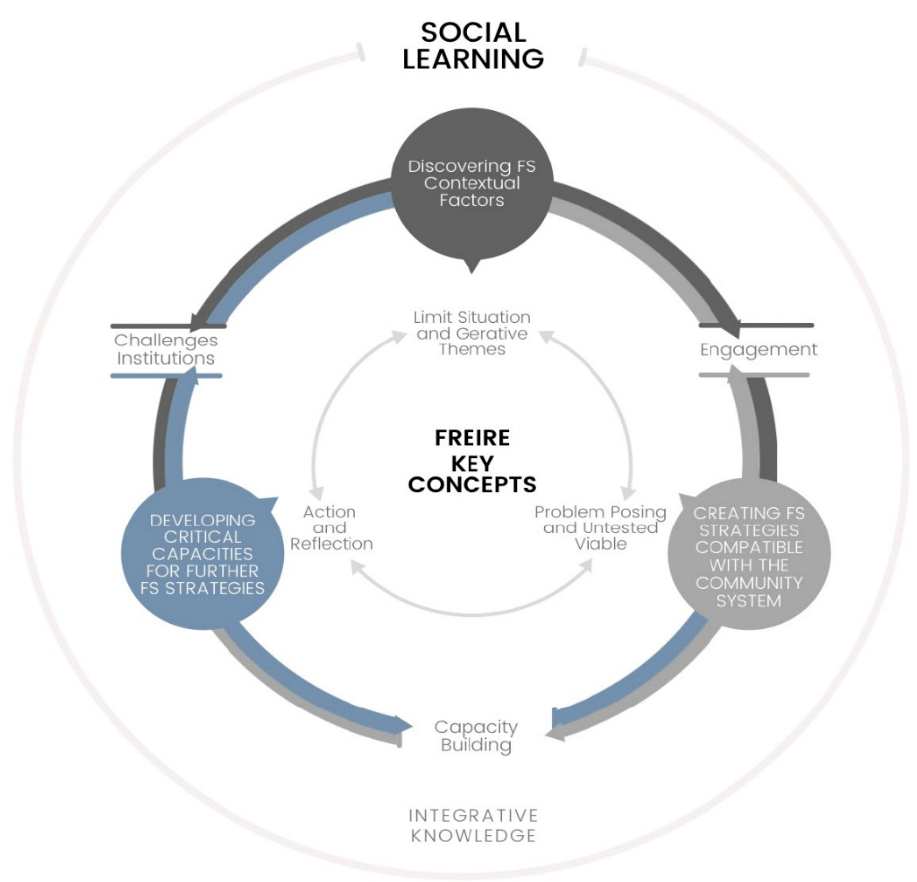
Figure 1. Interlinkages and interfaces of Freire’s key concepts, a food security key actions, and social learning dimensions. Source: Own.